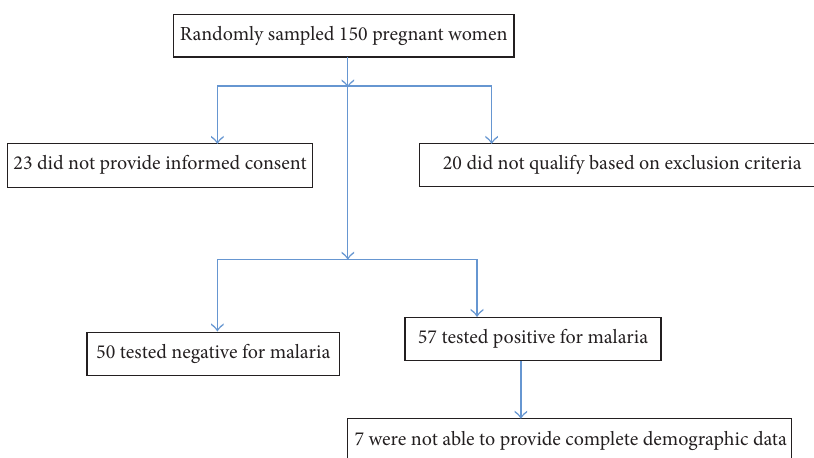
Figure 1: Flow chart of sample selection and